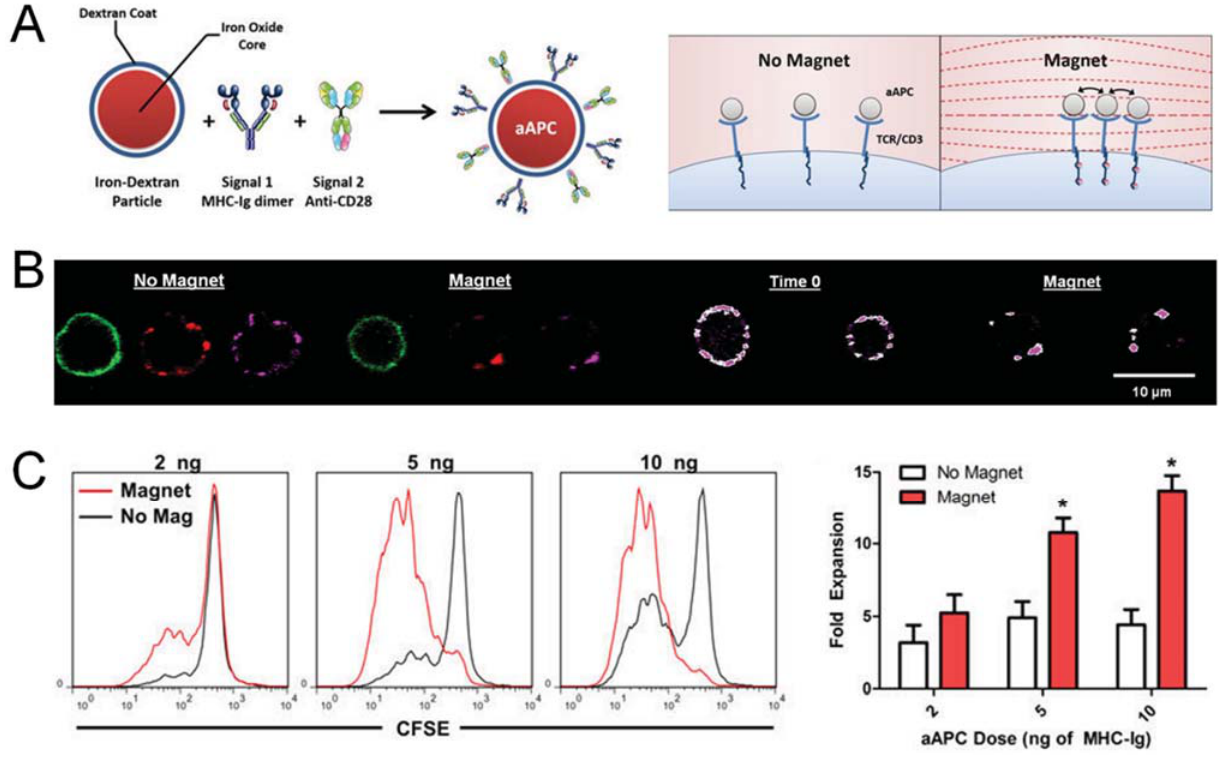
Figure 4. Artificial antigen-presenting cells (aAPCs) for activation of T cells. ( A ) aAPCs composed of an iron nanoparticle core and dextran shell conjugated with stimulatory molecules induced clustering of T-cell receptors (TCRs) under magnetic field; ( B ) TCR clustering was visualized by fluorescence imaging. Green, lymphocyte marker on T cells; red: aAPCs; magenta: CD3(cid:5) on T cells; ( C ) Proliferation of T cells was enhanced by aAPC- induced TCR clustering in vitro . Reproduced with permission